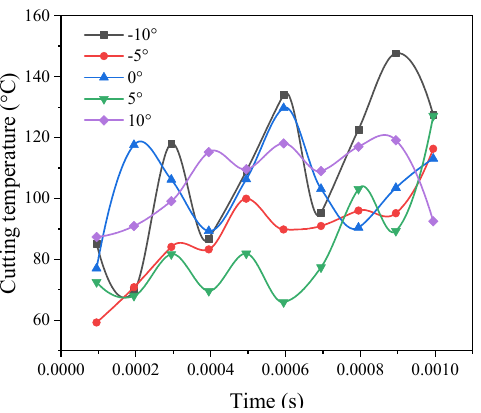
Figure 5. Comparison curve of the cutting temperature under different tool rake angles.